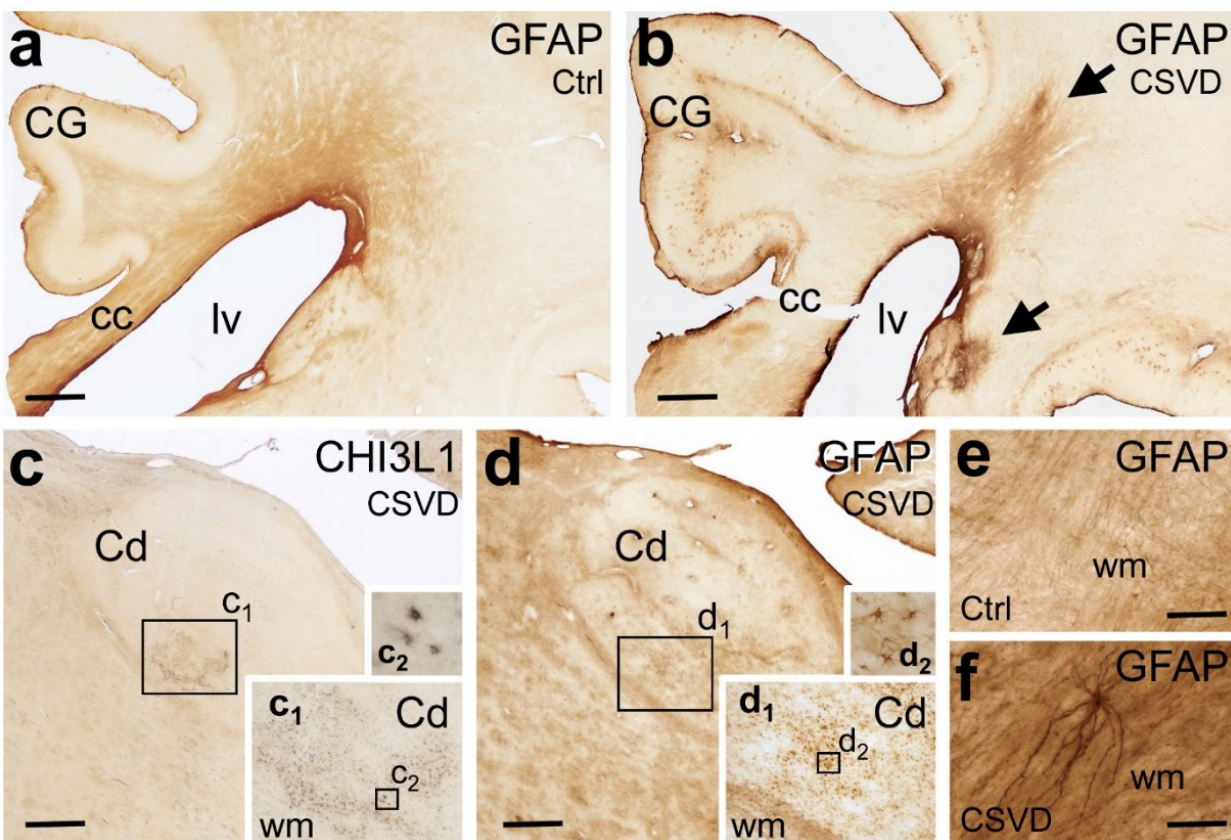
Figure 6. Immunohistochemical demonstration of the astroglial markers glial acid fibrillary protein (GFAP) and chitinase 3-like 1 (CHI3L1) in 100-µm-thick mid-hemisphere sections in CSVD and the controls. ( a , b ) CSVD case ( b ; Case # 1) with MRI-visible white matter hyperintensities (WMH) displays stronger GFAP immunoreactivity in the white matter (arrows) than the case with acute stroke but only minor subcortical CSVD and no WMH ( a ; Case # 12). ( c , d ) CSVD case ( c , d ; Case # 7) with clusters of CHI3L1-positive astrocytes in the caudate nucleus (Cd) in the absence of immunoreactive astrocytes in the neighbouring white matter. The density of GFAP-expressing reactive astrocytes is also high in the Cd, whereas the surrounding white matter tracts contain bundles of GFAP-positive fibrillary astrocytic processes. Boxed areas in ( c ) with CHI3L1-positive glial cell clusters and in ( d ) with GFAP-positive glial cell clusters are shown at higher magnification in the insets ( c1 , c2 ) and in the insets ( d1 , d2 ), respectively. ( e , f ) At higher magnification, the periventricular white matter of CSVD cases ( f ; Case # 5) presents with a much higher density of GFAP-positive fibrillary astrocytic processes than controls ( e ; Case # 9). Cc: corpus callosum, Cd: caudate nucleus, CG: cingulate gyrus, CHI3L1: chitinase-3-like protein 1, CSVD: cerebral small vessel disease, Ctrl: control, GFAP: glial fibrillary acidic protein, lv: lateral ventricle and WMH: white matter hyperintensities. Scale bars: 1000 µm ( a – d ) and 100 µm ( e , f ). Table 2. GFAP and CHI3L1 immunoreactivity in the periventricular white matter in CSVD cases and the controls. Quantitative histopathological analyses of the white matter (wm) area with en- hanced GFAP expression (area measured in cm 2 ) and with CHI3L1-positive cell clusters (number within a 10-mm radius) around the central part of the lateral ventricle at the mid-hemispheric level. In CSVD cases, the medial periventricular zone (PVM) with strong GFAP expression extends much further into the lateral periventricular zone (PVL), with moderate enhancement of the GFAP expres- sion when compared to the controls. Moreover, enhanced GFAP expression in the PVL of some CSVD cases extends farther to the deep white matter, often reaching the cortex of the superior frontal gyrus (§). ACA = anterior cerebral artery; Art. = arterial; Ctrl = control; CRF = chronic renal failure; CSVD = cerebral small vessel disease; f = female; m = male, L = left; MCA = middle cerebral artery; mm = millimetre; PCA = posterior cerebral artery; PV = periventricular region; PVL = lateral periventricular region; PVM medial periventricular region; R = right; Staging AD/A β = staging for Alzheimer-related neurofibrillary tangles/A β deposits [24]; TIA = transient ischaemic attack; wm = white matter. * p < 0.05, ** p ≤ 0.01. No Age Sex Group Diagnosis